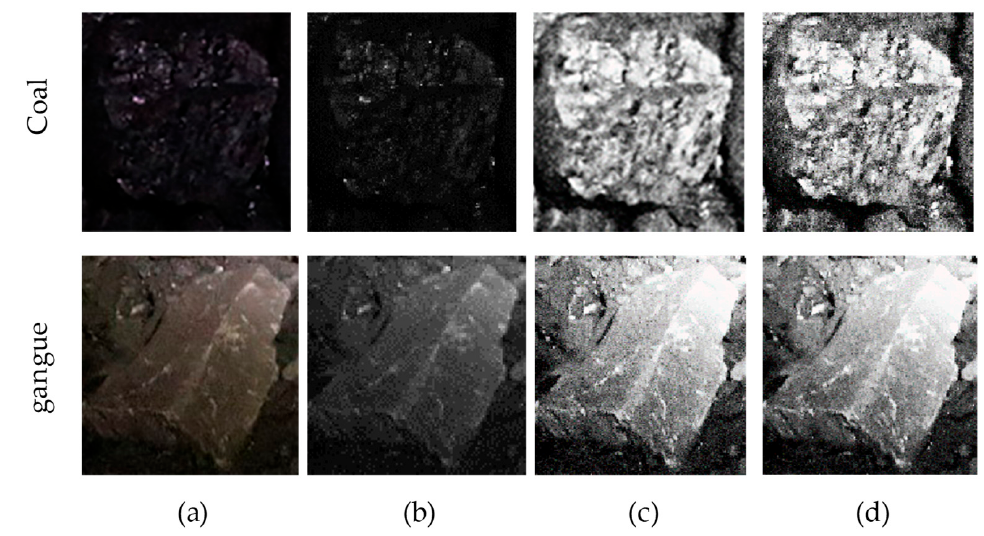
Figure 4. Effect comparison of the coal and gangue images before and after preprocessing: ( a ) raw image, ( b ) gray conversion, ( c ) gamma correction, and ( d ) enhancement.